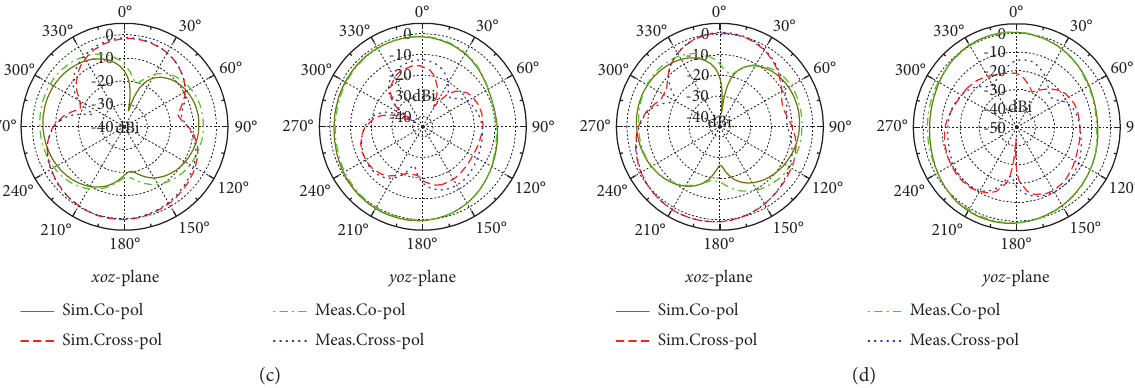
Figure 17: Radiation pattern of two-port antenna simulation and measurement at (a) 4GHz, (b) 6 GHz, (c) 8GHz, and (d) 10GHz.